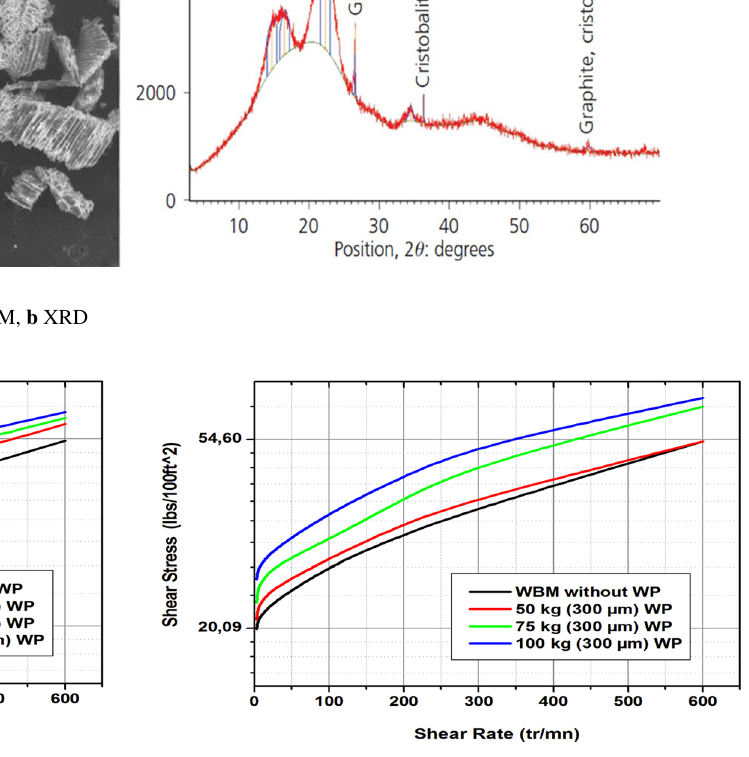
Fig. 2 PAC_ul and CMC substituted by wood powder (WP at size = 100 µm) at different contents